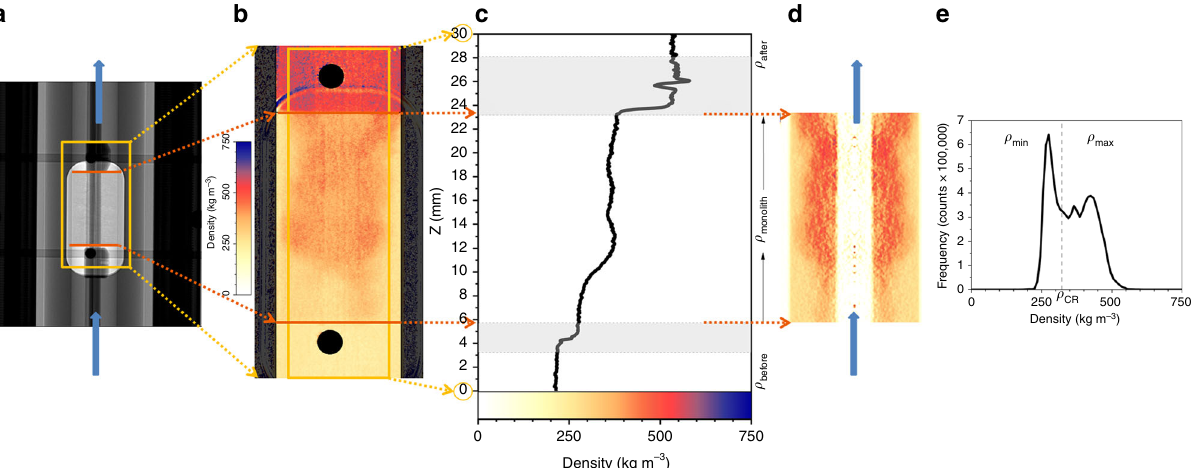
Fig. 2 Example of the results presentation. a Neutron image of the monolith inside the continuous fl ow tubular reactor: the blue arrows indicate the water fl ow direction, the red lines indicate the monolith edges and the yellow square indicates the region of interest for images processing. b Color-scaled density map: LL supercritical water is reddish, GL supercritical water is yellowish and liquid water is blueish; the yellow square indicates the region of interest for the vertical density pro fi le. c Water density pro fi le: the three density regions of interest are marked by ρ before , ρ monolith , and ρ after ; the gray zones were not taken into consideration for density calculation, as they are image artifacts induced by the monolith edges and the reactor ’ s window for neutrons. d Tomographic reconstruction of the monolith region and e Computed histogram showing the volume fraction of densities ρ max and ρ min within the monolith region. Source data for c and e are provided as a Source Data fi